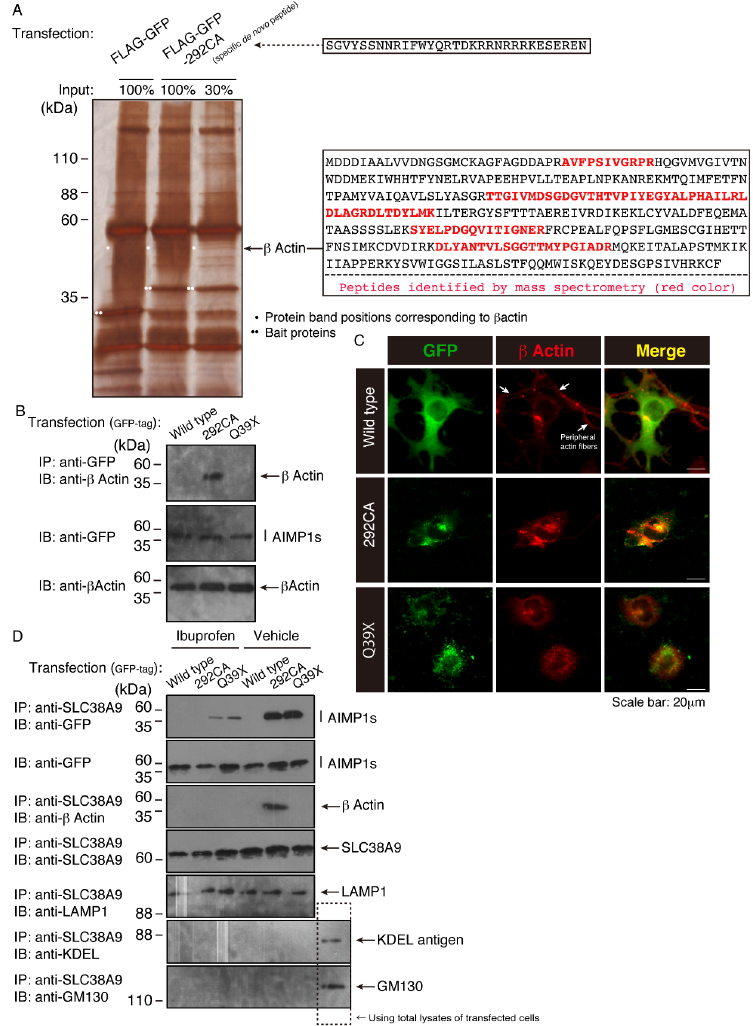
Figure 9. The 292CA mutant proteins interact with actin and treatment with ibuprofen decreases this interaction. ( A ) The total amounts (100%) or 30% of all immunoprecipitates from human 293T cell lysates expressing the control FLAG-GFP or the 292CA-specific de novo peptide with FLAG-GFP tag (right upper letters) were subjected to a denatured polyacrylamide gel and the gel was silver-stained (left image). The resultant peptides digested from an approximately 50-kDa protein specific to 292CA were analyzed with an Ettan MALDI-TOF Pro mass spectroscope and identified as human actin ( β type actin, right bottom letters with red color [mass spectroscopically-identified peptides]). The single and double white circles indicate proteins corresponding to actin position and bait, respectively. ( B ) N1E-115 cells were transfected with the plasmid encoding the wild type construct or the 292CA or Q39X mutant of GFP-tagged AIMP1 and lysed. The lysates were immunoprecipitated (IP) with an anti-GFP antibody and immunoblotted (IB) with an anti-actin antibody (upper panel). The lysates were also immunoblotted with an antibody against GFP or actin (middle or bottom panel). ( C ) N1E-115 cells transfected with the respective GFP-tagged AIMP1 constructs (green) were immunostained with an anti-actin antibody (red). Merged images are also shown. The arrows indicate actin fibers in the cell periphery, which are seen only in the case of transfection with the wild type. The scale bars indicate 20 µ m. ( D ) Lysates of transfected N1E-115 cells in culture with or without ibuprofen were immunoprecipitated with an anti-SLC38A9 antibody (for the lysosome) and immunoblotted with an antibody against GFP (for each of the AIMP1 constructs), actin, SLC39A9, LAMP1, KDEL antigen, or GM130. The immunoblots for GFP-tagged AIMP1 proteins (the wild type or each of the mutants), KDEL antigen, or GM130 for total lysates are